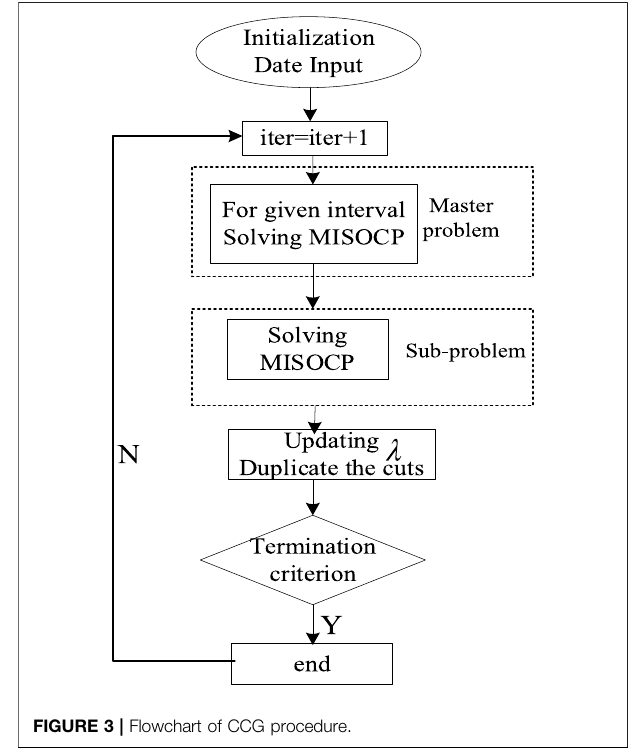
FIGURE 3 | Flowchart of CCG